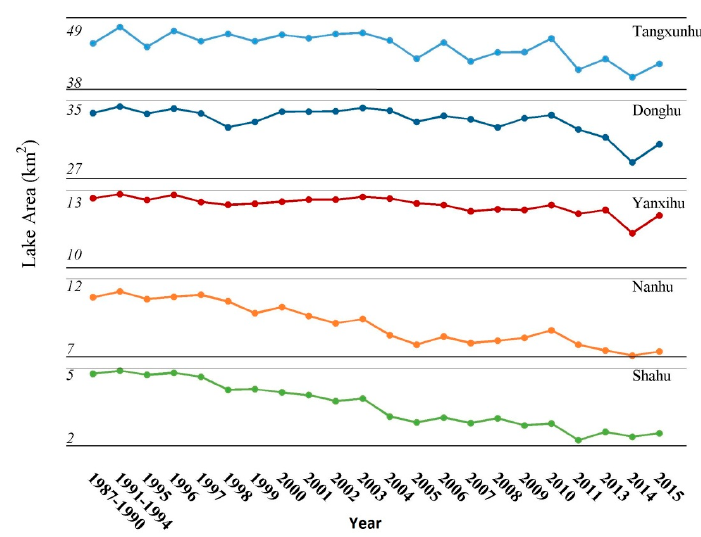
Figure 7. Lake water extent changes from 1987~2015.